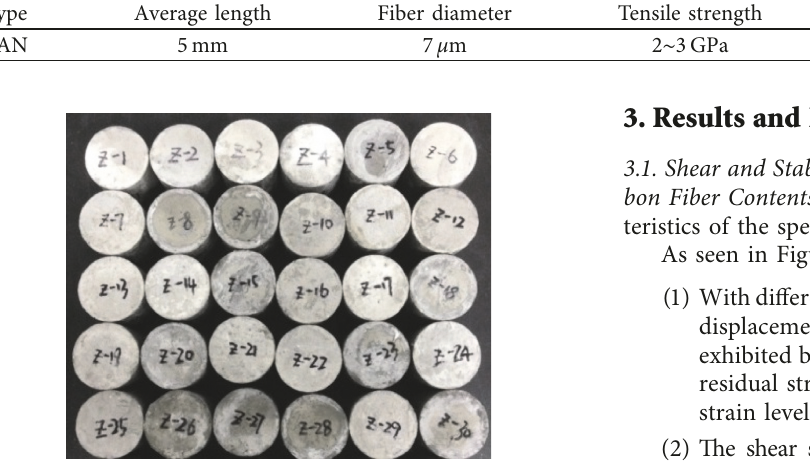
Figure 1: Experimental specimens with different carbon fiber